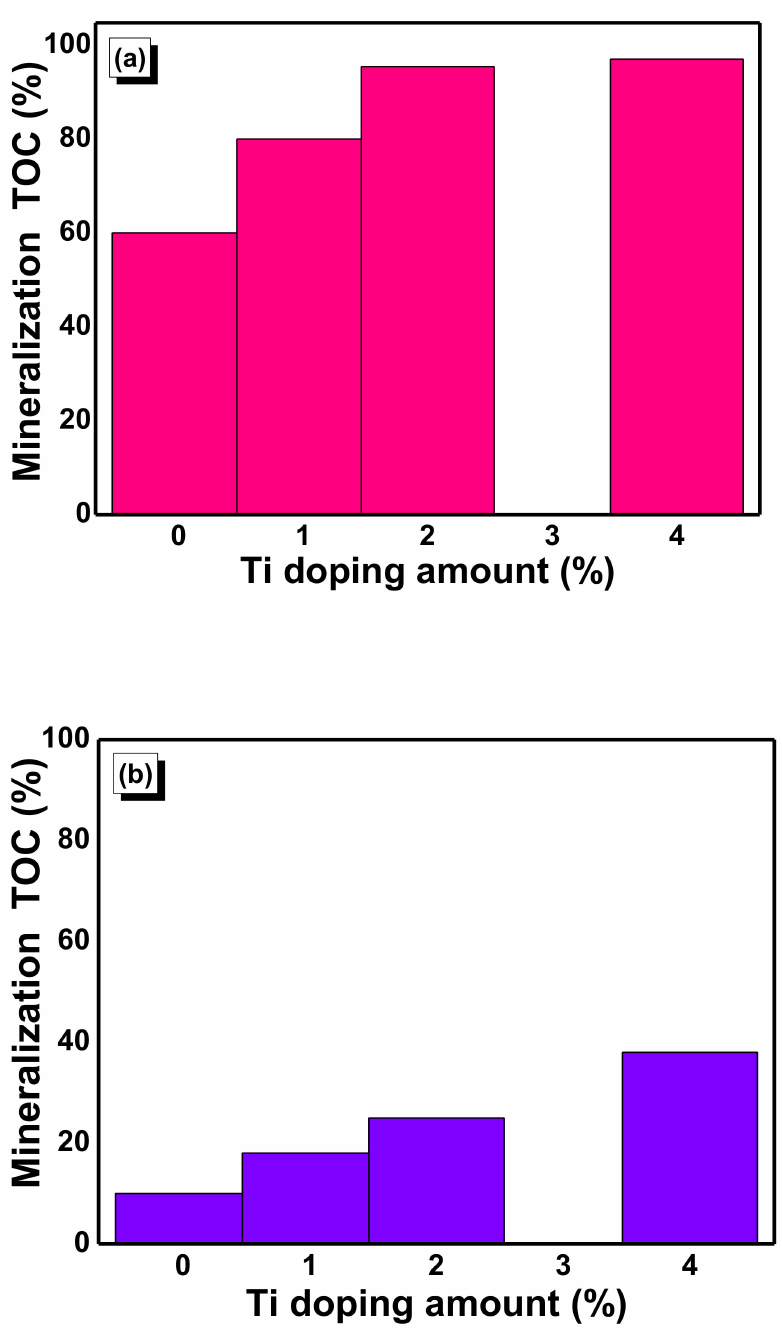
Figure 13. Bar diagram for the degradation rate of rhodamine B dye (TOC) in the presence of SnO2: Ti photocatalysts ( a ) Under UV irradiation and ( b ) under visible